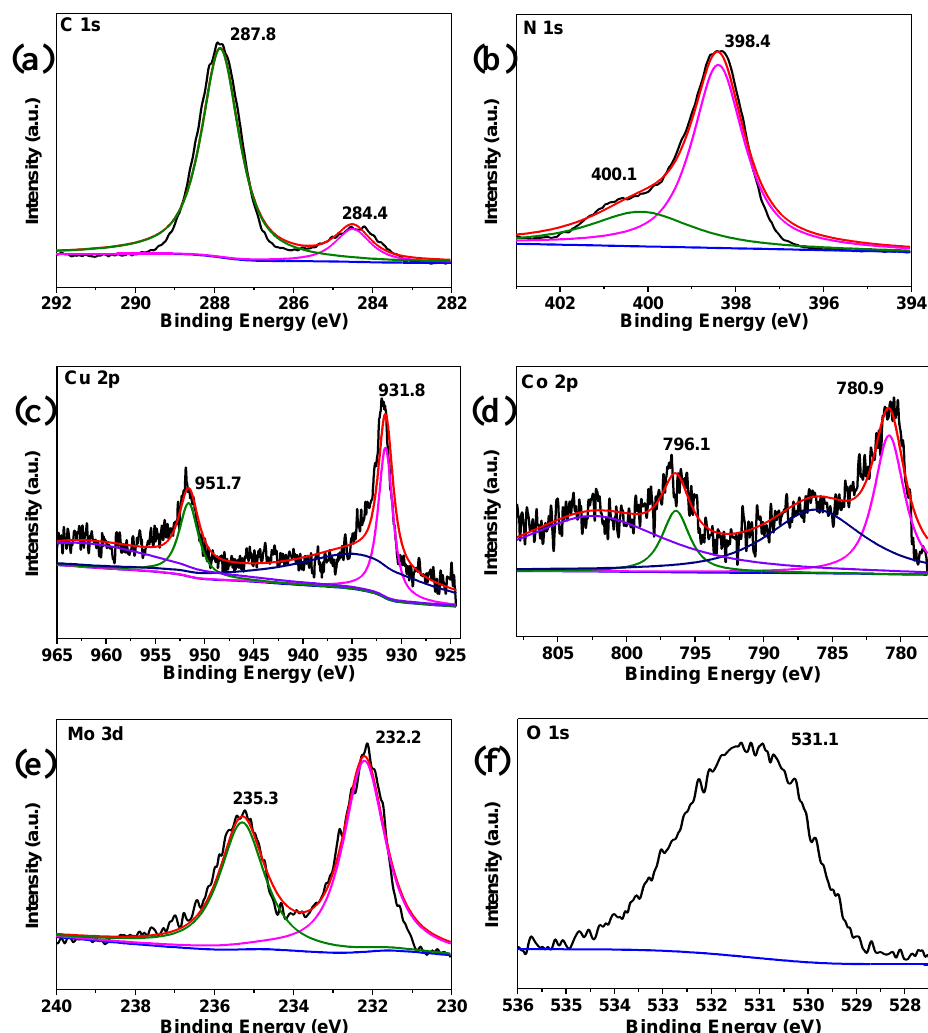
Figure 4. XPS pattern of Cu 0.4 Co 0.6 MoO 4 / g-C 3 N 4 : ( a ) C 1s; ( b ) N 1s; ( c ) Co 2p; ( d ) Cu 2p; ( e ) Mo 3d; ( f ) O 1s.